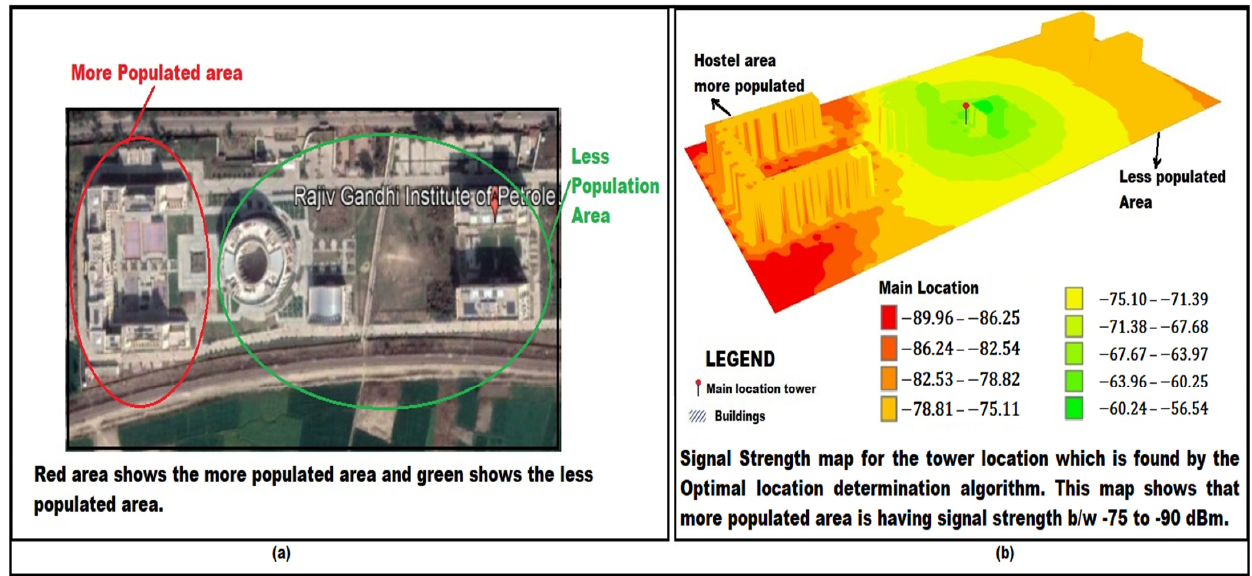
Figure 13. ( a ) RGIPT area with non-uniform population. ( b ) Signal strength map for the main location initially determined by the proposed method.